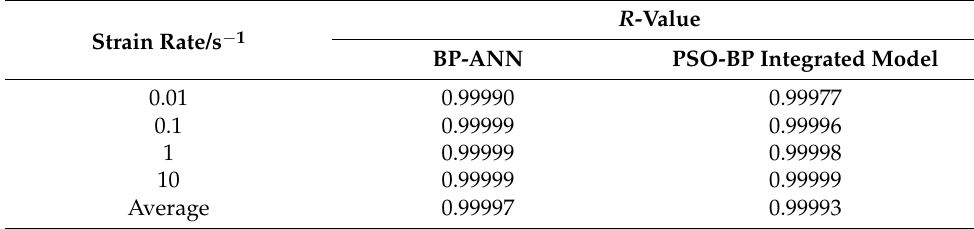
Table 6. R -values between the training datasets and fitted values of the BP-ANN and PSO-BP integrated model under different strain rates.